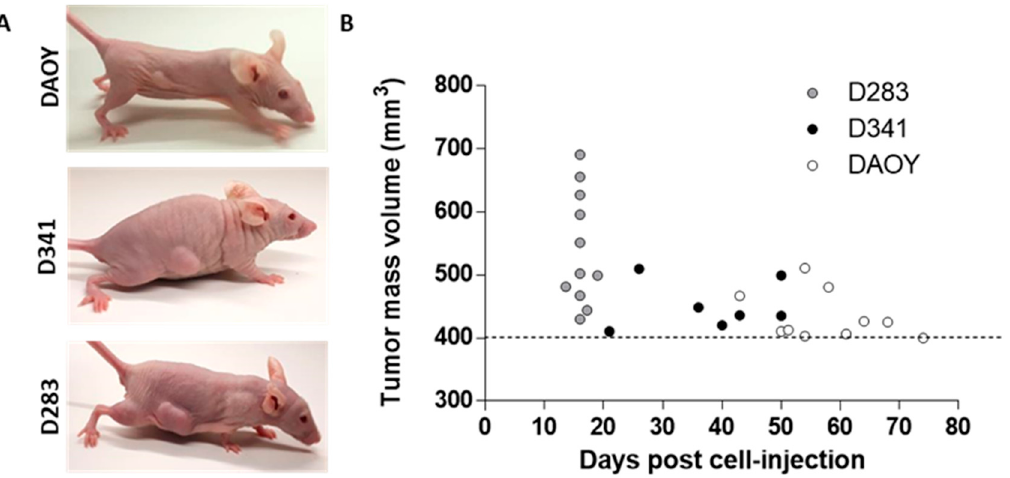
Figure 4. Tumor-propagating capacity. Representative pictures of tumor masses with different dimension at 16 days post-implantation ( A ). Time of appearance of tumors with a volume of ≥ 400 mm 3 ( B ).